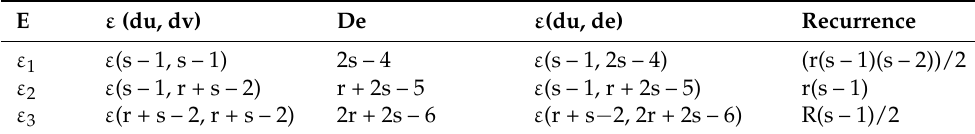
Table 1. Edge partition of the cloud network.